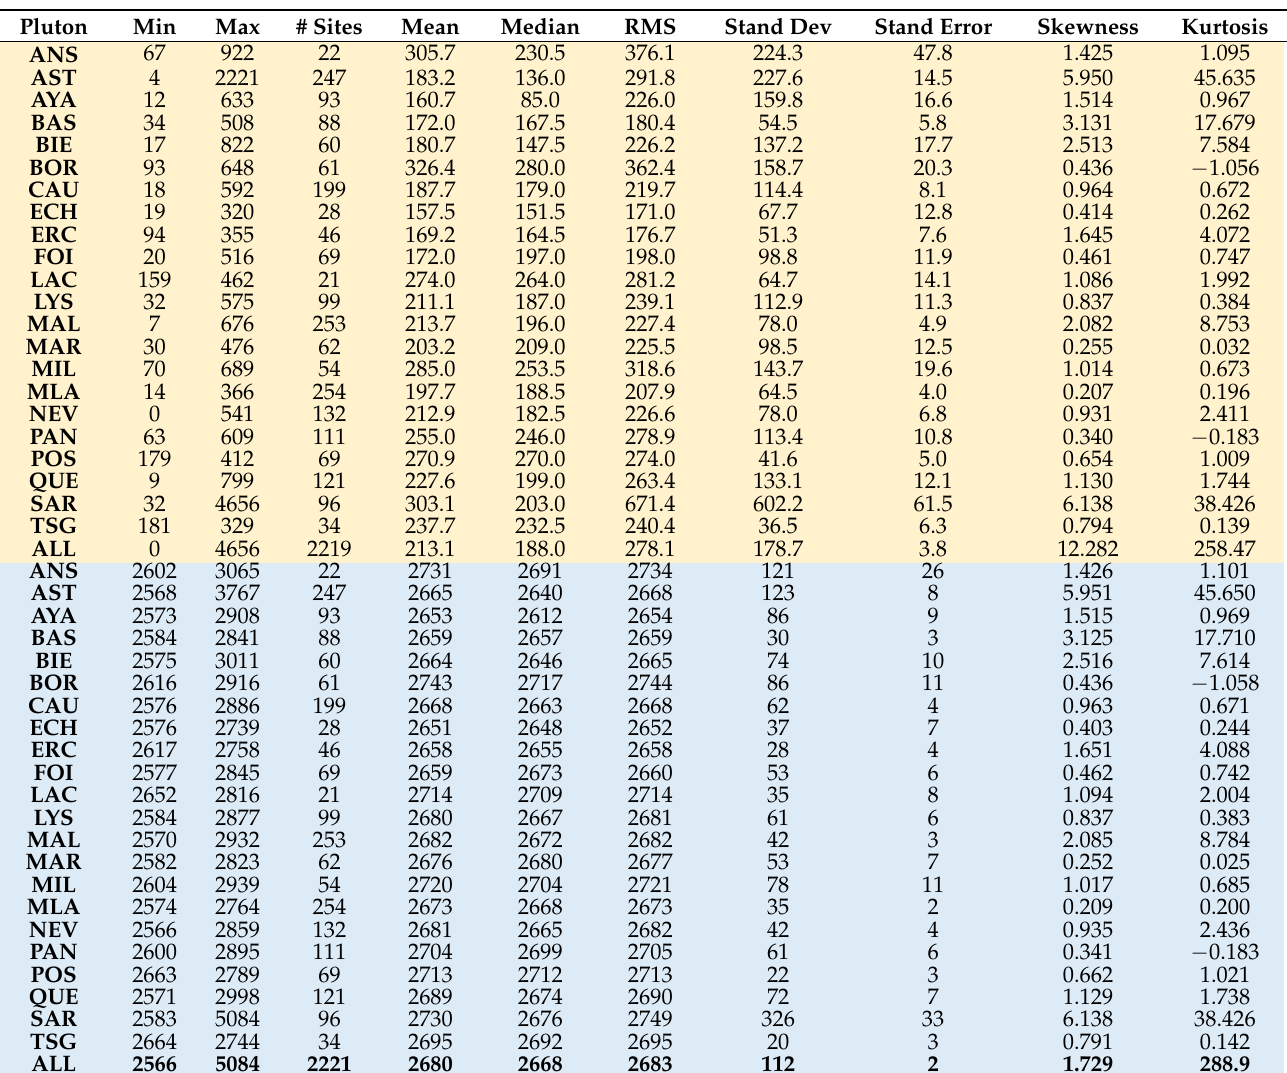
Table 6. Overview of deduced density (this work) and magnetic susceptibility statistical parameters (compilation by Porquet et al. [44] found in the 22 granitic bodies from the Pyrenees. Aston (AST), Aya (AYA), Bassies (BAS), Bielsa (BIE), Borderes (BOR), Cauterets (CAU), Eaux Chaudes (ECH), Erce (ERC), Foix (FOI), Lacourt (LAC), Lys (LYS), Maladeta (MAL), Marimanha (MAR), Millares (MIL), Mont Luis-Andorra (MLA), Neouville (NEV), Panticosa (PAN), Posets (POS), Querigut (QUE), StArnac (SAR), Trois